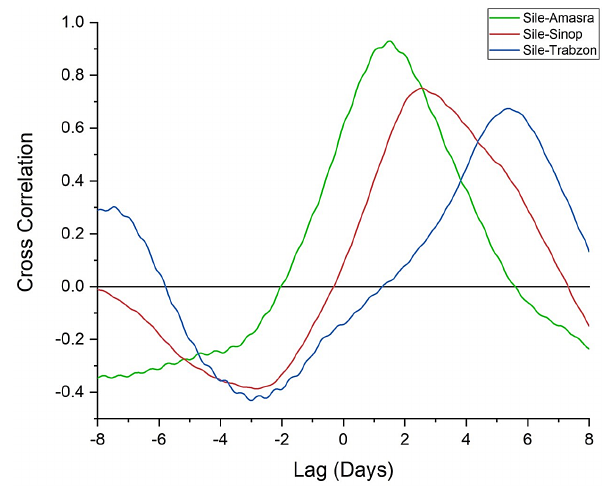
Figure 6. Time-lagged correlations between the sea level at the westernmost station (Sile) and those at other stations towards the east for October–November 2014.